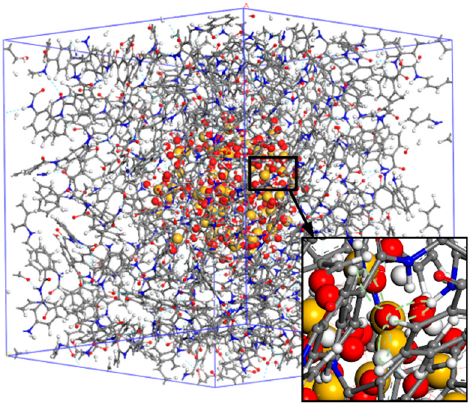
Figure 7. Local enlargement of hydrogen bonding in the SiO 2 /PMIA model.